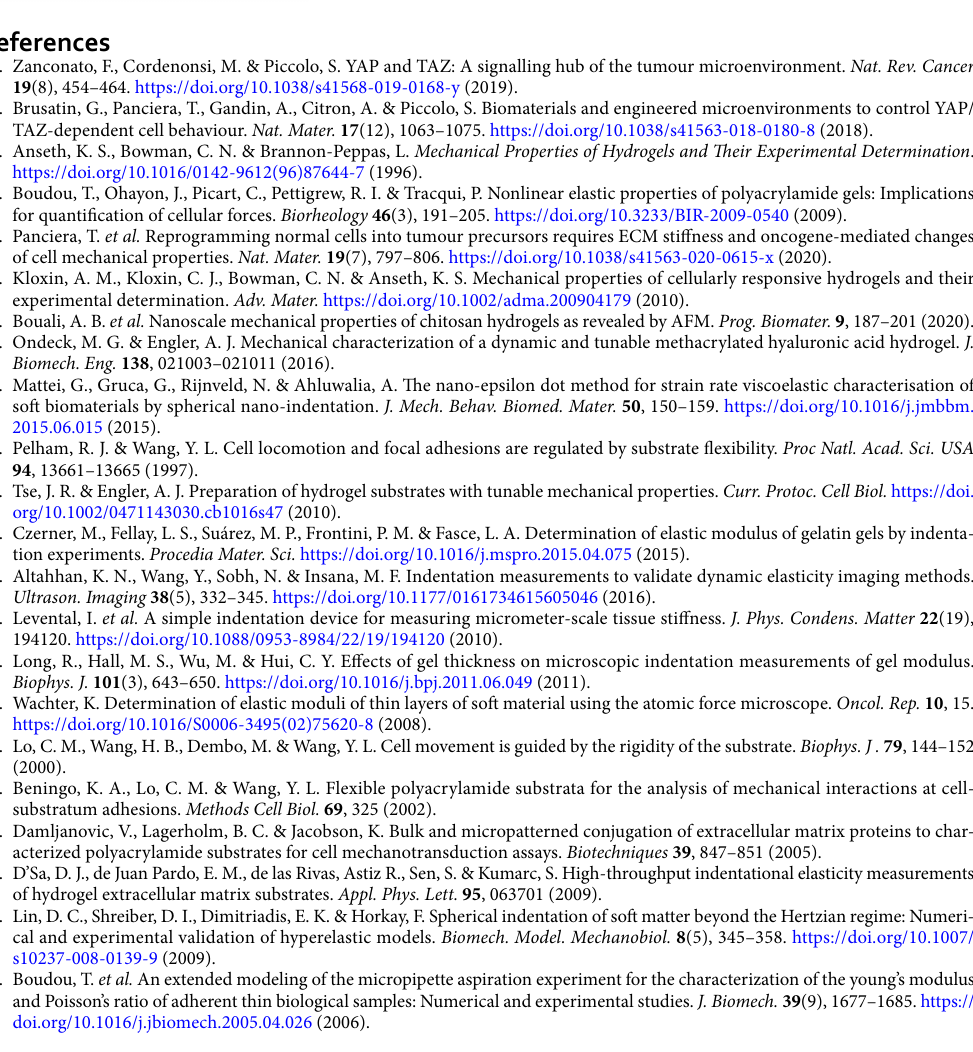
in a row, the subsequent incremental step is increased by a factor 0.5. In Fig. 4, the finite element mesh is shown along with the normal displacement field of the deformed hydrogel.